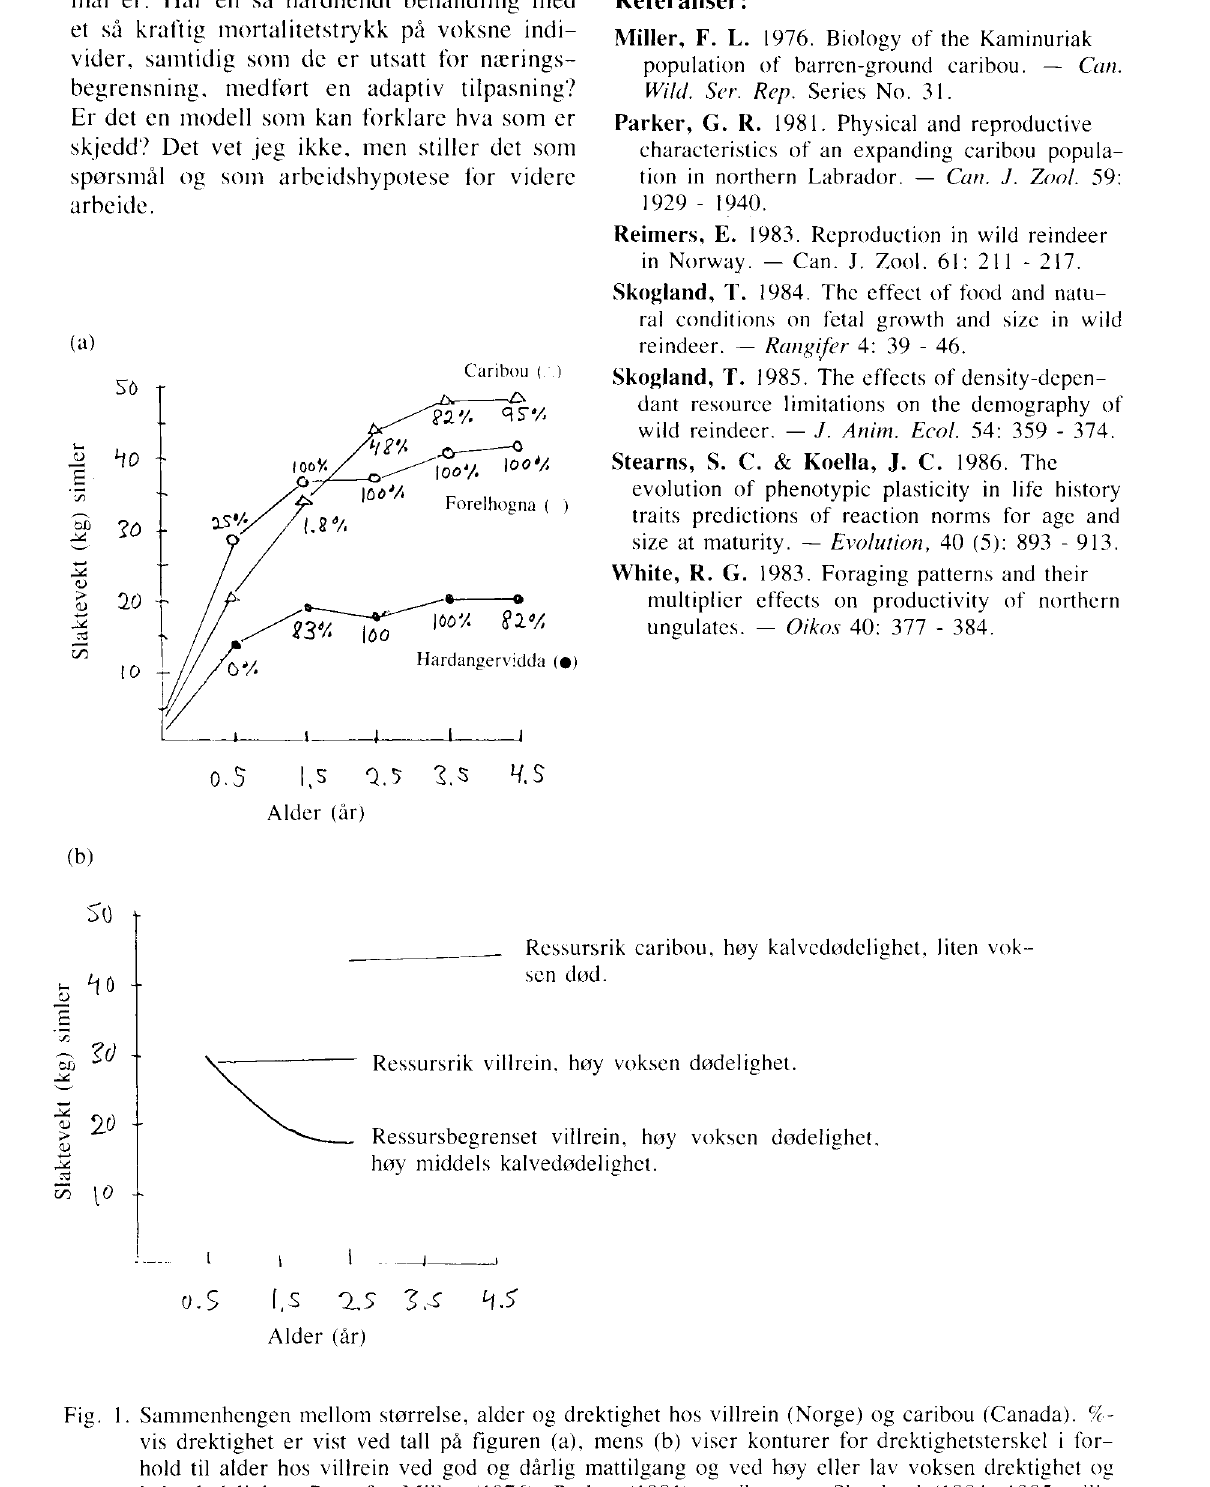
Fig. 1. Sammenhengen mellom størrelse, alder og drektighet hos villrein (Norge) og caribou (Canada). %- vis drektighet er vist ved tall på figuren (a), mens (b) viser konturer for drektighetsterskel i for hold til alder hos villrein ved god og dårlig mattilgang og ved høy eller lav voksen drektighet og kalvedødelighet. Data fra Miller (1976), Parker (1981), caribou) og Skogland (1984, 1985, vill